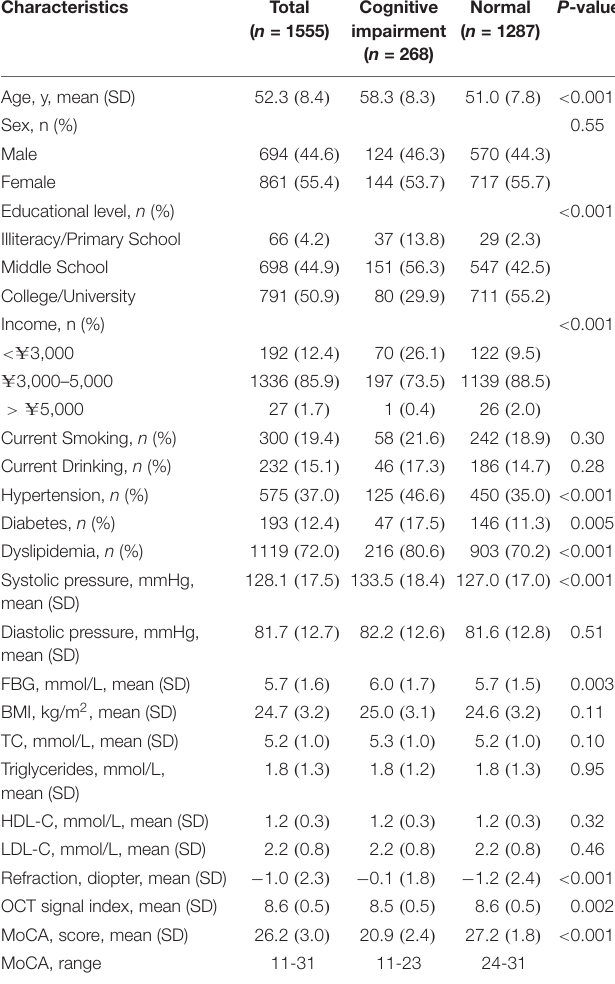
TABLE 1 | Baseline characteristics of eligible participants in the